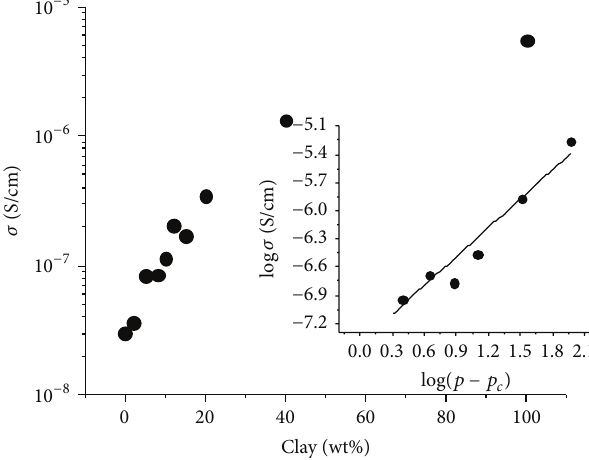
Figure 3: XRD patterns of chitosan and CS-MMN composites with different concentrations of montmorillonite indicated on the graph.